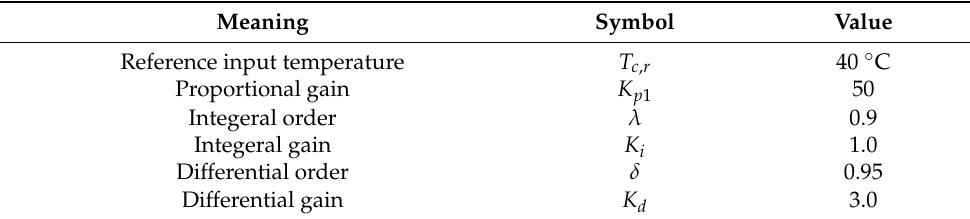
Table 5. Tuning parameters for FOPID Controller without operator controller.